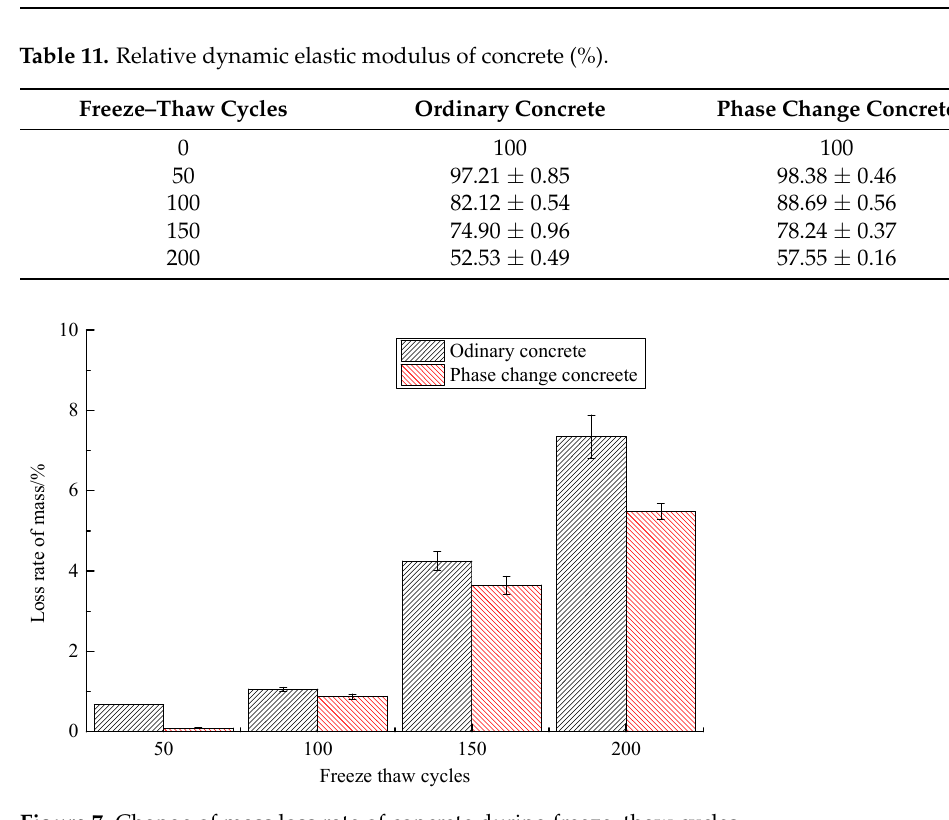
Figure 8. Comparison of relative dynamic elastic modulus. 3.3.3. Mechanical Properties The changes in compressive strength of concrete during freeze–thaw are shown in Table 12 and Figure 9, and the changes in the splitting tensile strength are shown in Table 13 and Figure 10. As can be seen from these graphs, the compressive and the splitting tensile strength of concrete continue to decrease as freeze–thaw cycles increase, but the addition of phase change material reduces the loss of mechanical properties to some ex- tent. After 50 freeze–thaw cycles, the compressive strength loss of phase change concrete and ordinary concrete is 16.79% and 18.30%, respectively, which is not a big difference, while the splitting tensile strength of the former improves more obviously at this time.